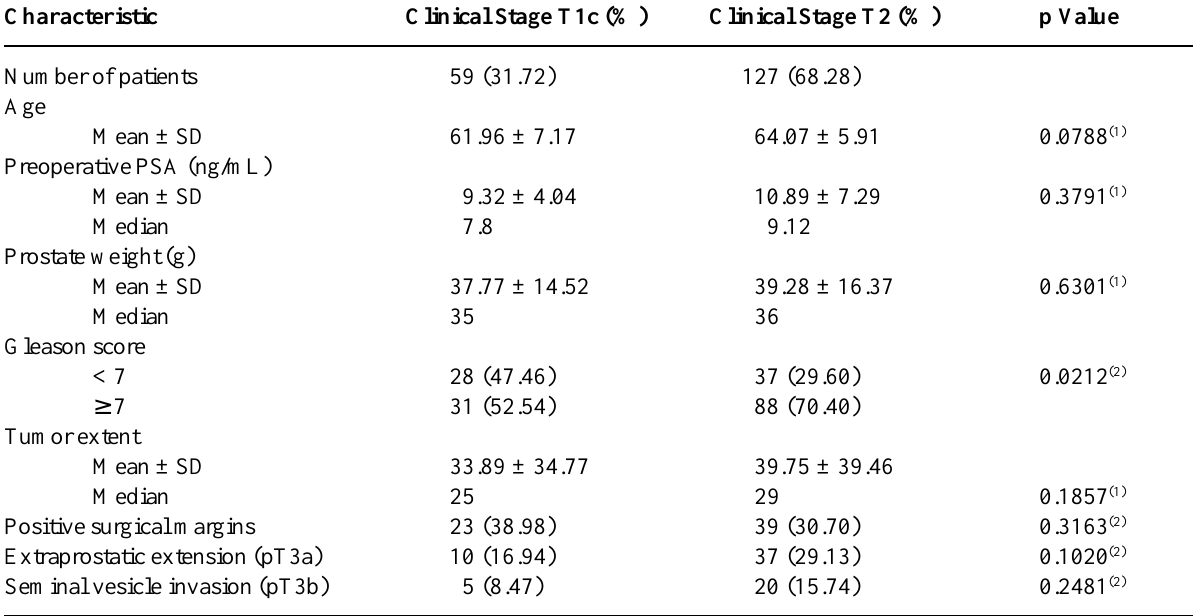
Table 1 – Clinicopathologic features of men undergoing radical prostatectomy, by clinical stage.